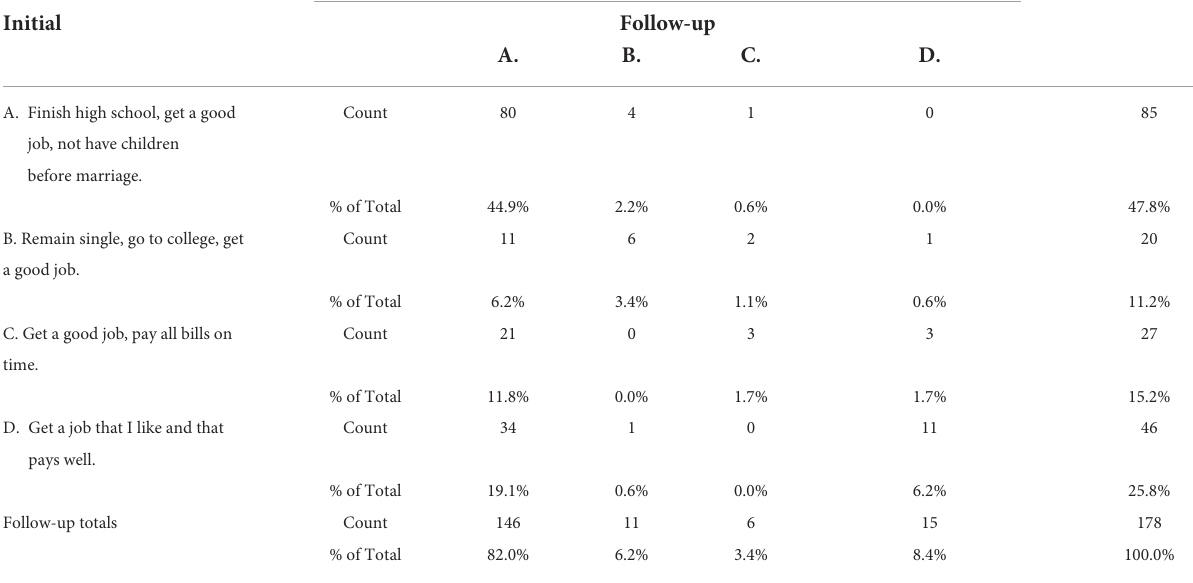
TABLE 2 Initial (pre-test) by follow-up (post-test) knowledge test item (Group 2). To have the most successful life a person